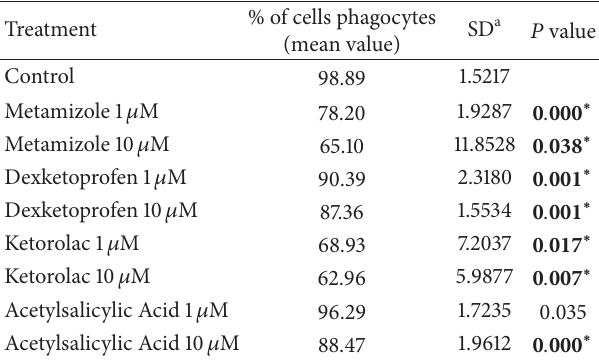
Table 3: Percentage of cells with phagocyte capacity determinate by flow cytometry; treated with metamizole, dexketoprofen, ketorolac, and acetylsalicylic acid at doses of 1 and 10 𝜇 M.